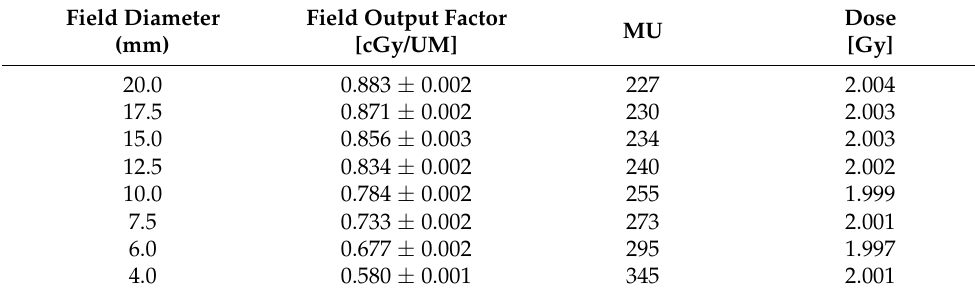
Table 5. Output factors for estimating the delivered dose and calculating the MU.